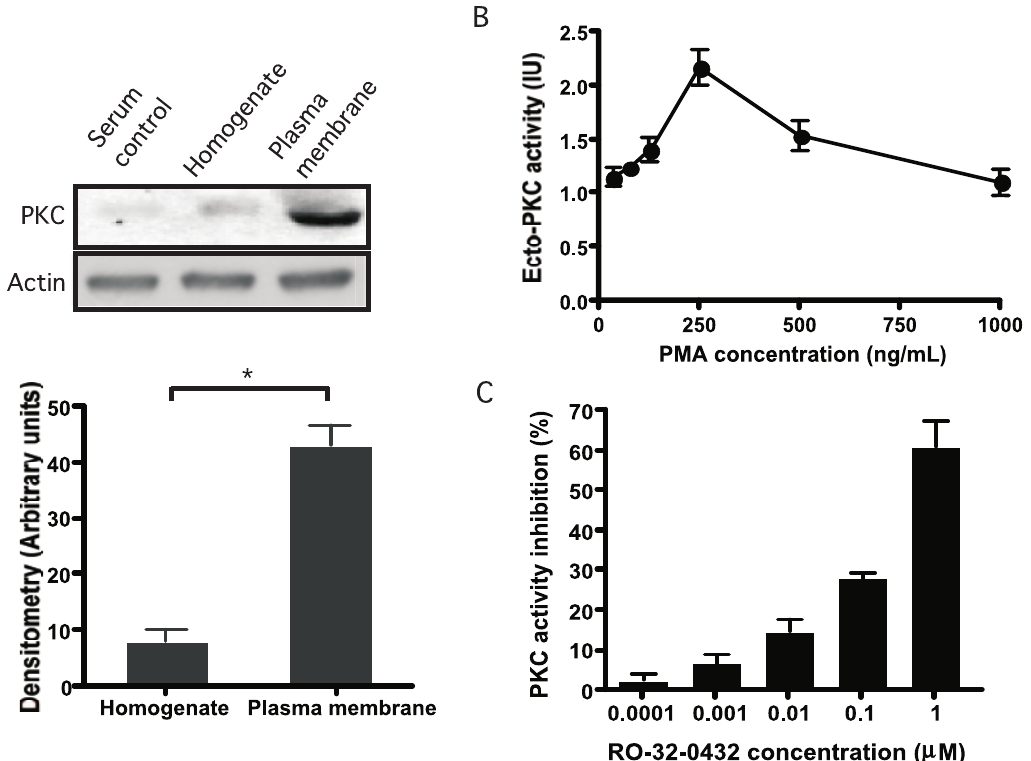
Figure 1. Protein kinase C-like detection on stationary promastigotes. (A): Immunoblot detection of PKC-like in subcellular fractions of stationary promastigotes of L. mexicana . Cell pellets (2.5 6 10 9 cells/ml) were resuspended in 0.02 M Tris-HCl supplemented with 0.25 M sucrose and 3 mM MgCl 2 . Cells were homogenized and sonicated in a Branson Sonifier 250 W, then resuspended in a buffer containing protease inhibitors and centrifuged at 100000 g for 1 hour at 4 u C. Membrane fraction (pellets) and whole homogenates were directly used for immunoblot detection of PKC using a mouse monoclonal anti-PKC a , b I , b II antibody. (B): Ecto-PKC-like activity on intact stationary promastigotes of Leishmania. Promastigotes of L. mexicana were resuspended in 25 mM Tris-HCl, pH 7.0, 3 mM MgCl 2 , 0.1 mM ATP, 2 mM CaCl 2 , 50 m g/ml phosphatidylserine, 1 mM EGTA, 0.5 mM EDTA, 0.1 mM PMSF, 1 mM benzamidine. Phorbol myristate acetate (PMA) was added to cell suspensions in concentration ranging from 0.035 to 1 m g/ml and incubated for 15 min. at 30 u C. After washes, promastigotes were incubated for 30 min at 30 u C with the biotinylated antibody 2B9. PKC activity was revealed by a peroxidase-conjugated streptavidin antibody coupled to ortho-phenyldiamine substrate. Plates were read at 492 nm. Results of three different experiments were expressed in international units (IU/mg) of PKC 6 SD. (C): Ecto-PKC-like inhibition. In some experiments intact stationary promastigotes were pretreated with the PKC ab I e inhibitor RO-32-0432 in concentration ranging from 0.0001 to 1 m M during 1 hour at 26 u C. PKC activity was revealed by incubating with the biotinylated antibody 2B9. Results of three different experiments were represented as the percentage of PKC activity inhibition 6 SD.